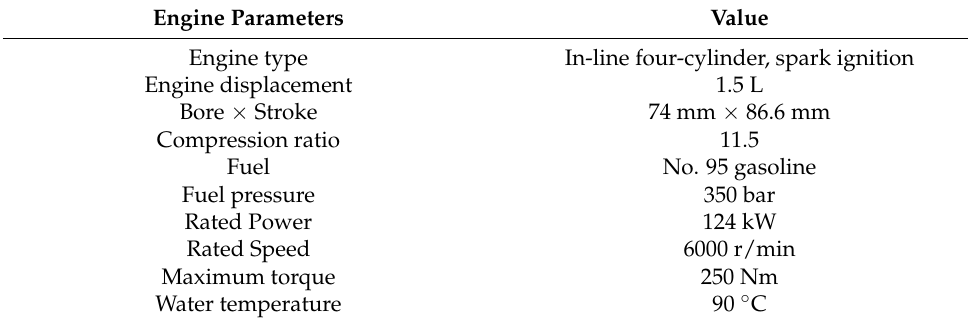
Table 1. The specifications of the test engine.